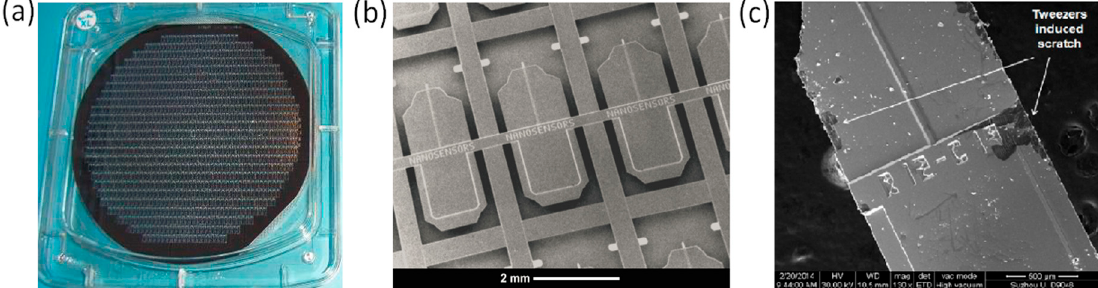
Figure 7. As-fabricated AFM probes by Nanoworld manufacturer. ( a ) Wafer scale of AFM probes; SEM images of ( b ) as-fabricated AFM probes. Reproduced with permission from Ref. [38], copyright Nanoworld GmbH 2008; ( c ) Individual probe scratched by tweezers when picking it up. Reproduced with permission from [28], copyright The Royal Society of Chemistry (2016).